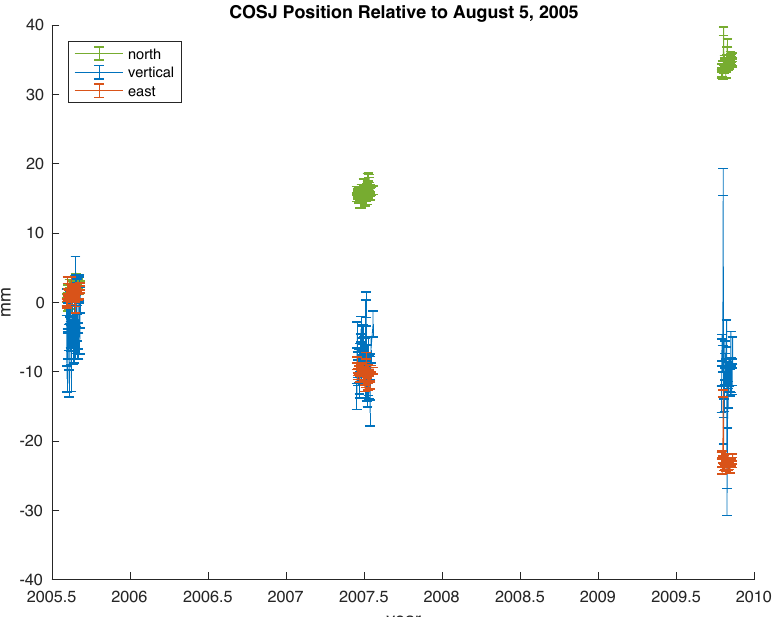
Figure 4. Time series of relative position in three components for continuous GPS station COSO. The northing component is shown in green, the easting component is shown in orange, and the vertical component is shown in blue. Vertical error bars denote measurement uncertainty. Measurements are shown with respect to 1 January 2003.